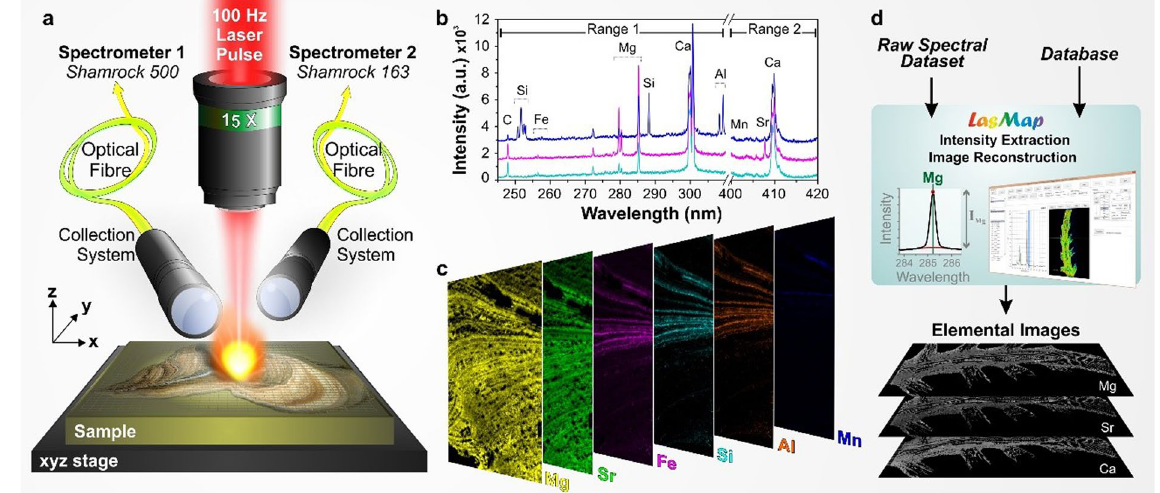
Figure 1. General protocol for LIBS imaging. ( a ) Schematic view of the LIBS instrument showing the major components: the microscope objective used to focus the laser pulse, the motorized platform supporting the sample and the two optical detection systems connected to different spectrometers via optical fibre bundles. ( b ) Sample single-pulse emission spectra covering spectral ranges between 245 and 310 nm (spectrometer 1) and between 400 and 420 nm (spectrometer 2) recorded in three different regions of the speleothem sample. These 3 spectra have been vertically shifted for better clarity. The characteristic emission lines of calcium (Ca), carbon (C), silicon (Si), iron (Fe), magnesium (Mg), aluminium (Al), manganese (Mn), and strontium (Sr) are clearly detected. ( c ) Sample relative-abundance images of Mg (red), Sr (cyan), Fe (violet), Si (yellow), Al (orange) and Mn (blue) represented using false colour scales for a 3000 × 1000 pixel sequence (resolution of 15 µ m). ( d ) Principle of data analysis using the LasMap